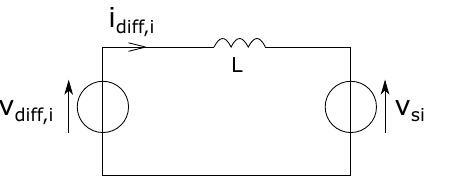
Figure 5. Equivalent circuit for “diff” components, i ∈ { a ; b ; c } .